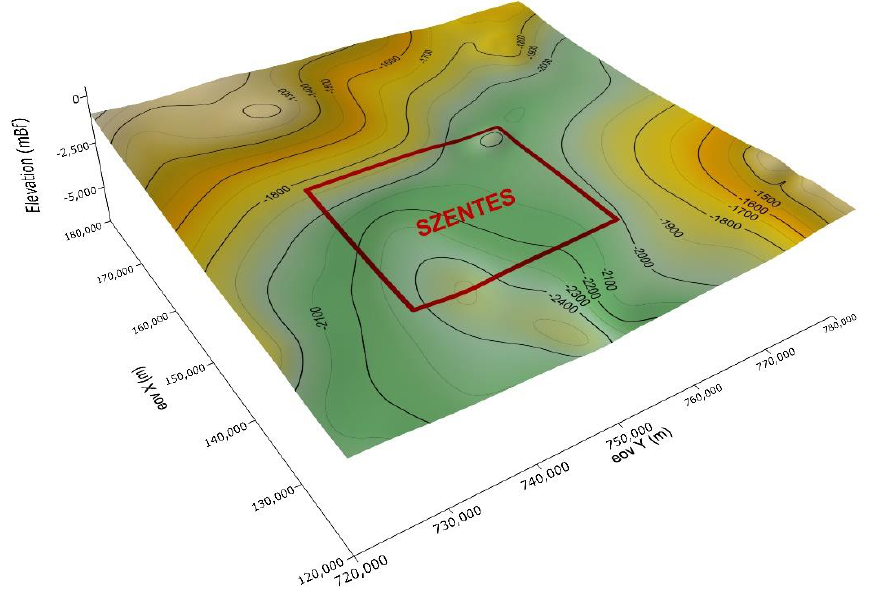
Figure 4. Depth map of Upper Pannonian formation top around Szentes study area (red rectangle) [25].